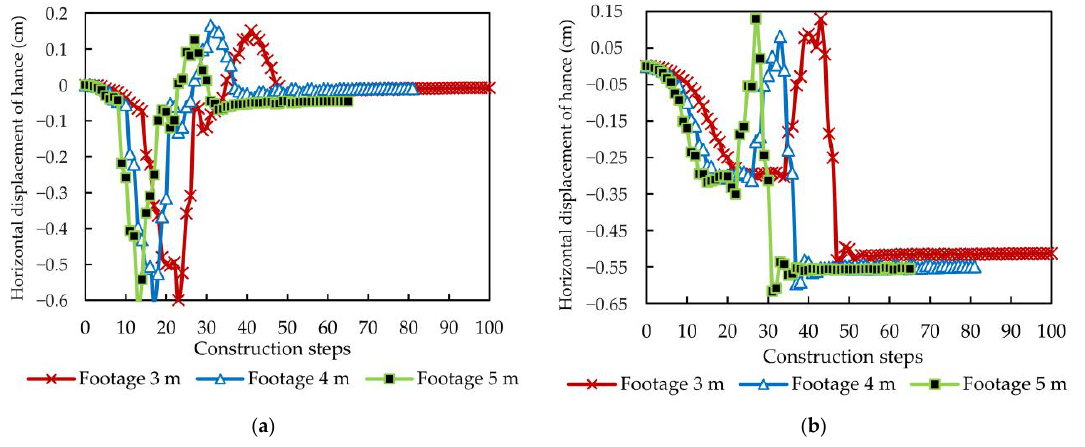
Figure 18. Variation curve of the horizontal displacement at the main line and the ramp hance: ( a ) Main line tunnel; ( b ) Ramp.